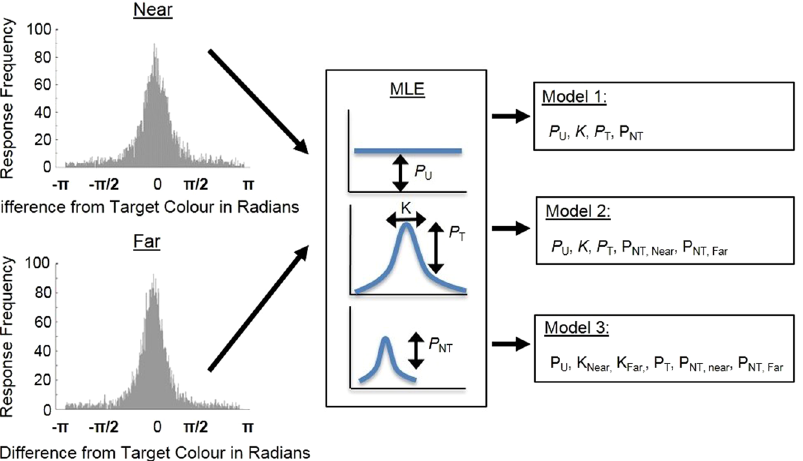
Figure 2. An illustration of the model comparison process. The Near and Far condition data was fit using Maximum Likelihood Estimation (MLE). The number of free parameters in the MLE is determined by the Model on the right. P T represents the probability of responding correctly to the target, P NT represents the probability of responding with the colour of the unprobed memory stimulus (the non-target), P U represents the probability of a response that did not match the colour of either of the two memory stimuli, which is interpreted as a guess, K represents the precision with which items are represented. In our “null hypothesis mixture model” (Model 1), we fit the Bays et al . mixture model 15 to the data from each participant and made no distinction between Near and Far conditions. For Model 2, only P NT could vary between Near and Far conditions. For Model 3, both K and P NT could vary between Near and Far